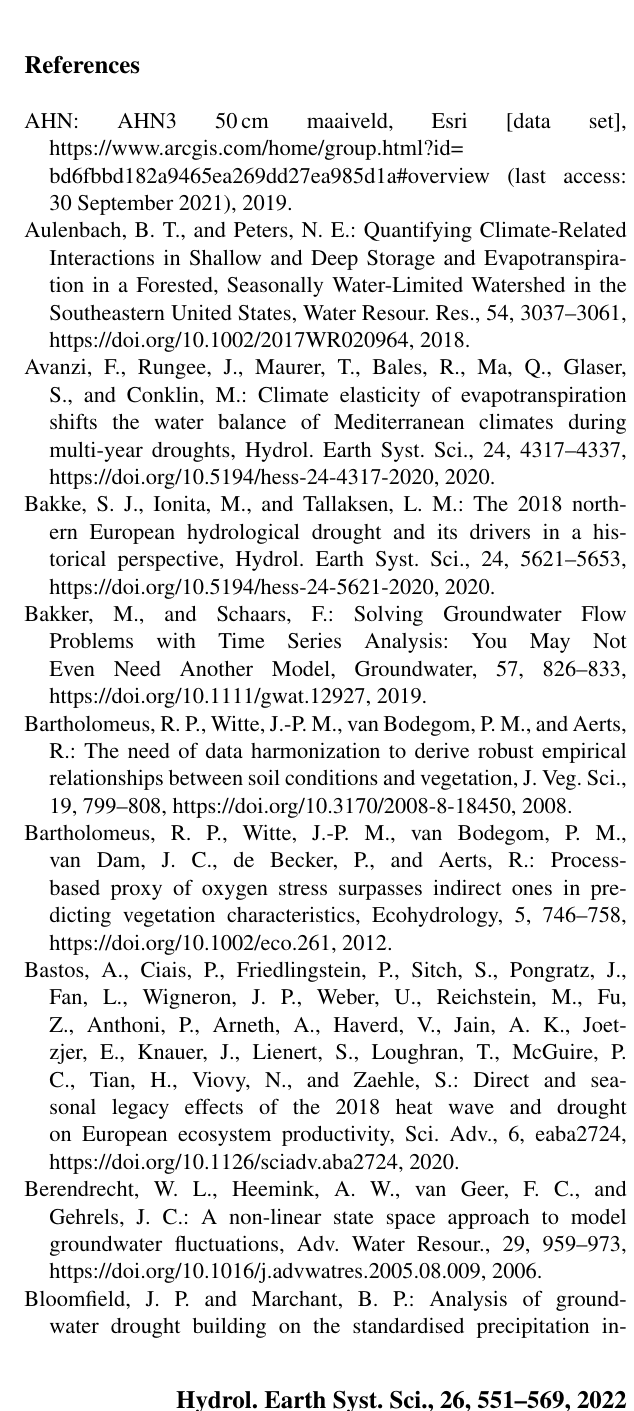
Table A1. Parameter calibration settings: initial value and bounds during optimisation (default settings in Pastas); the range of values found in this study when modelling the initial 2723 cleaned series; and reliability bounds used for the series classification. Initial Allowed Found Reliability value range values bounds for (Pastas) (Pastas) in this classification study (10th–90th